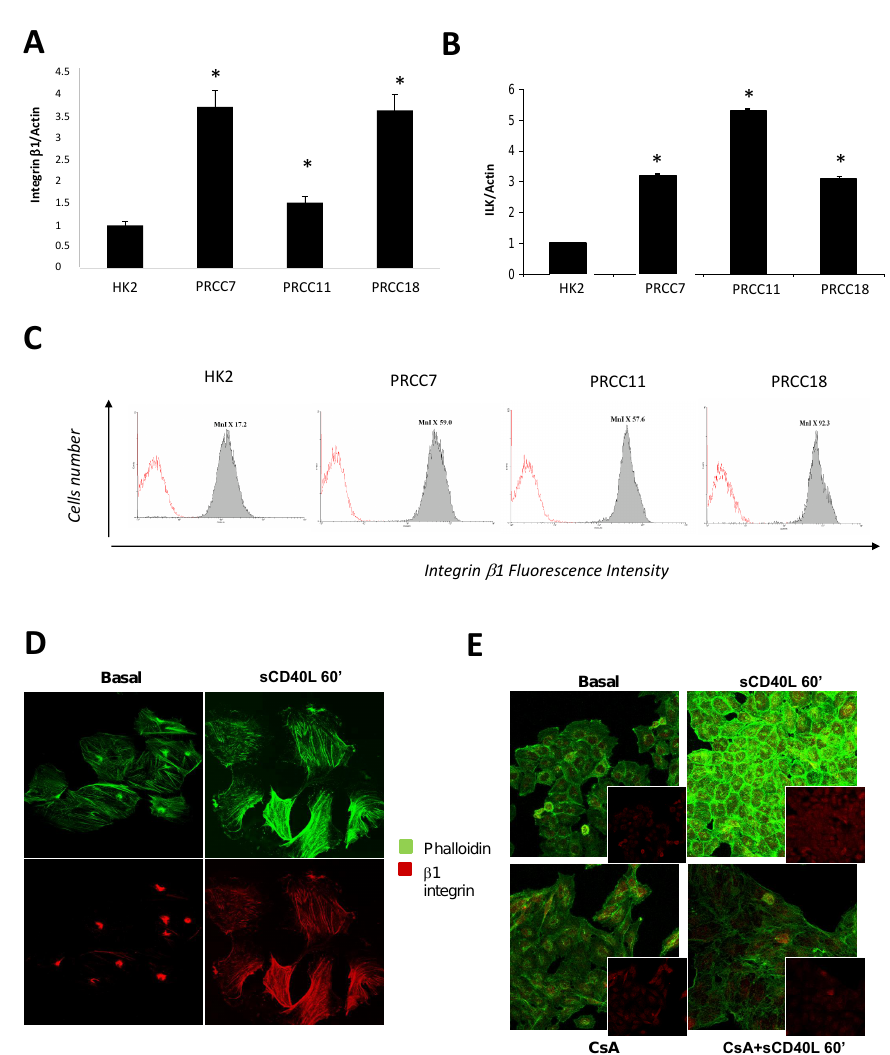
Figure 5. ( A ) Effect of CD40 ligation and NFATs inhibition on β 1 integrin and ILK expression and distribution. ( A , B ) β 1-integrin ( A ) and ILK ( B ) gene expression in RCC cell lines and HK2 cells. Real time PCR was performed as described in methods. * p < 0.05 vs. HK2 cells; ( C ) Flow cytometric expression of β 1-integrin on HK2 cells and different RCC cell lines. MnI (Mean fluorescent intensity) for each condition is reported in each box. ( D , E ) β 1-integrin and falloidin expres- sion in basal conditions and after CD40 ligation as well as in the presence or absence of cyclosporine A, were evaluated by confocal microscopy as described in methods. Images magnification 60 × . The figure is representative of three